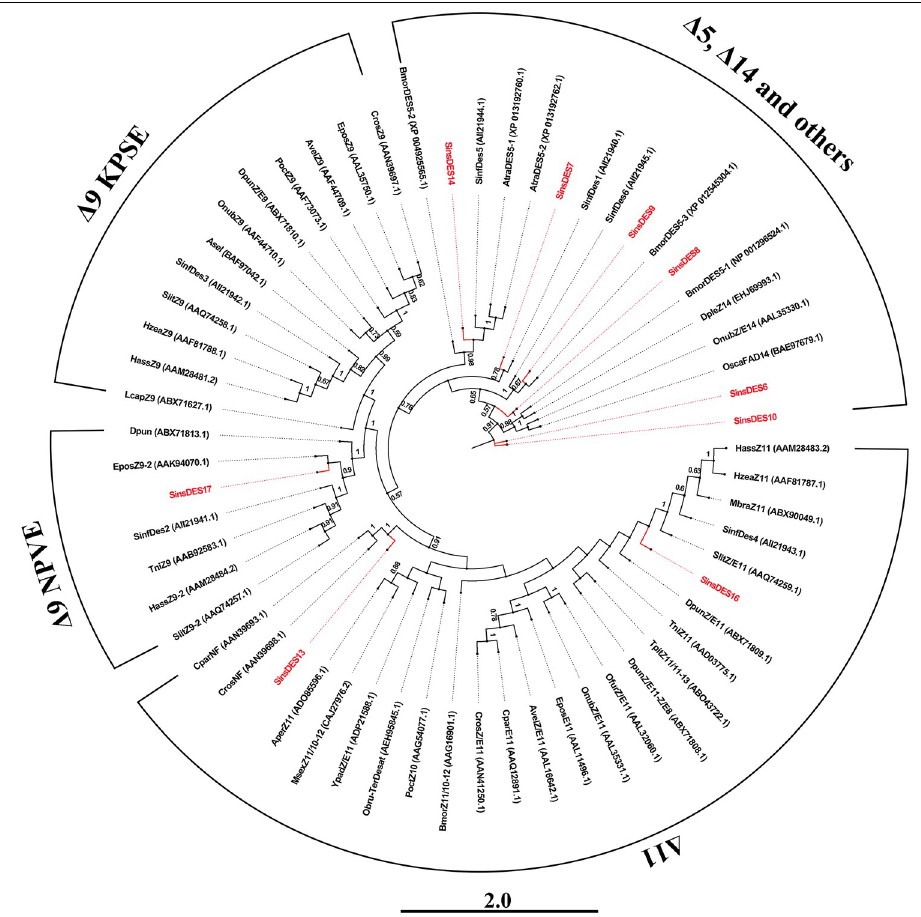
Fig 8. Neighbor-joining phylogenetic tree of selected Lepidopteran DES enzymes. The stability of nodes was assessed by bootstrap analysis with 1000 replicates, and only bootstrap values � 0.5 are shown at the corresponding nodes. The scale bar represents 2.0 substitutions per site. S . insularis sequences are colored